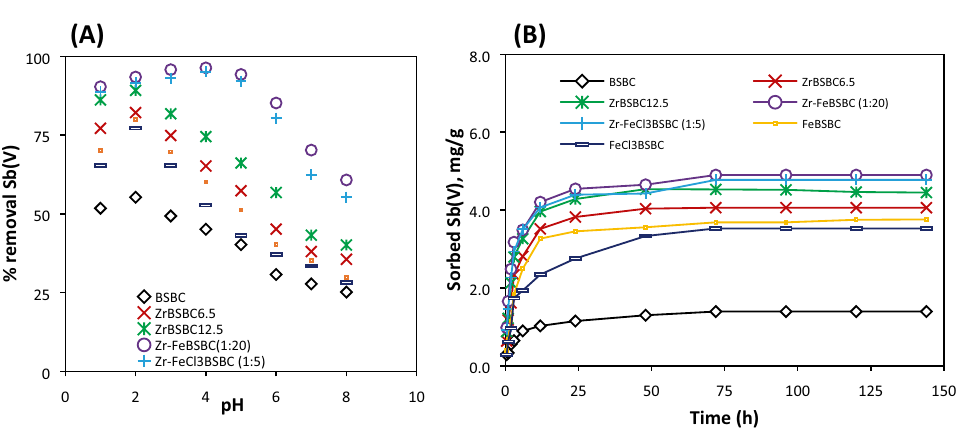
Figure 4. Effect of pH on removal percentage (%) of Sb(V), ( A ) [Initial concentration was 20 mg/L Sb(V), biochar dosage was 4 g/L, temperature was 22 °C] and effect of time on sorption capacity of Sb(V), ( B ) [Initial concentration 5 mg/L for BSBC, and 20 mg/L for ZrBSBC 6.5 , ZrBSBC 12.5 , Zr-FeBSBC(1:20), Zr-FeCl 3 BSBC (1:5), Fe-BSBC and